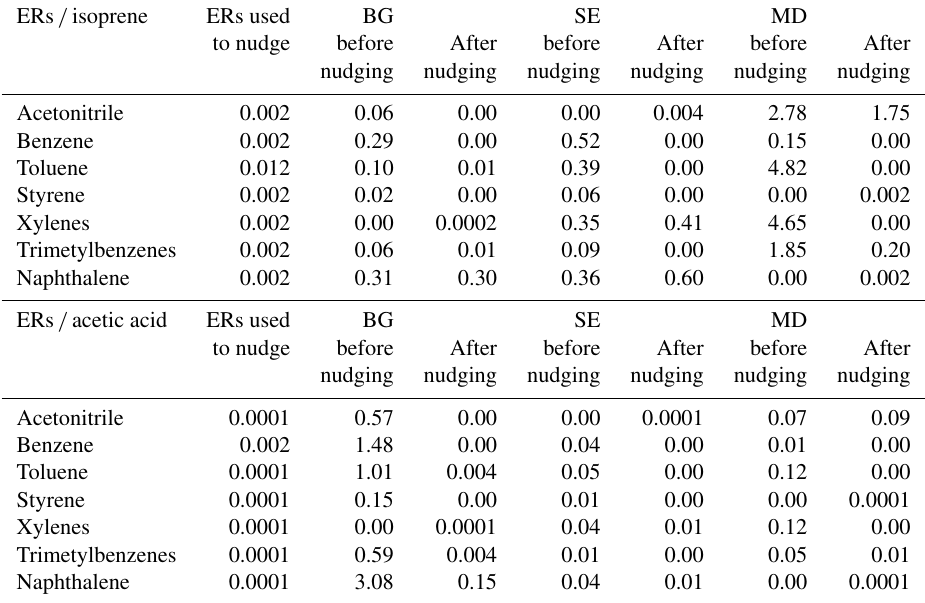
Table 2. Inter-NMVOC emission ratios used for biogenic, solvent evaporation and mixed daytime factors to nudge the PMF model and the corresponding emission ratios before and after nudging. ERs / isoprene ERs used MD to nudge before After before After before After nudging nudging nudging nudging nudging nudging